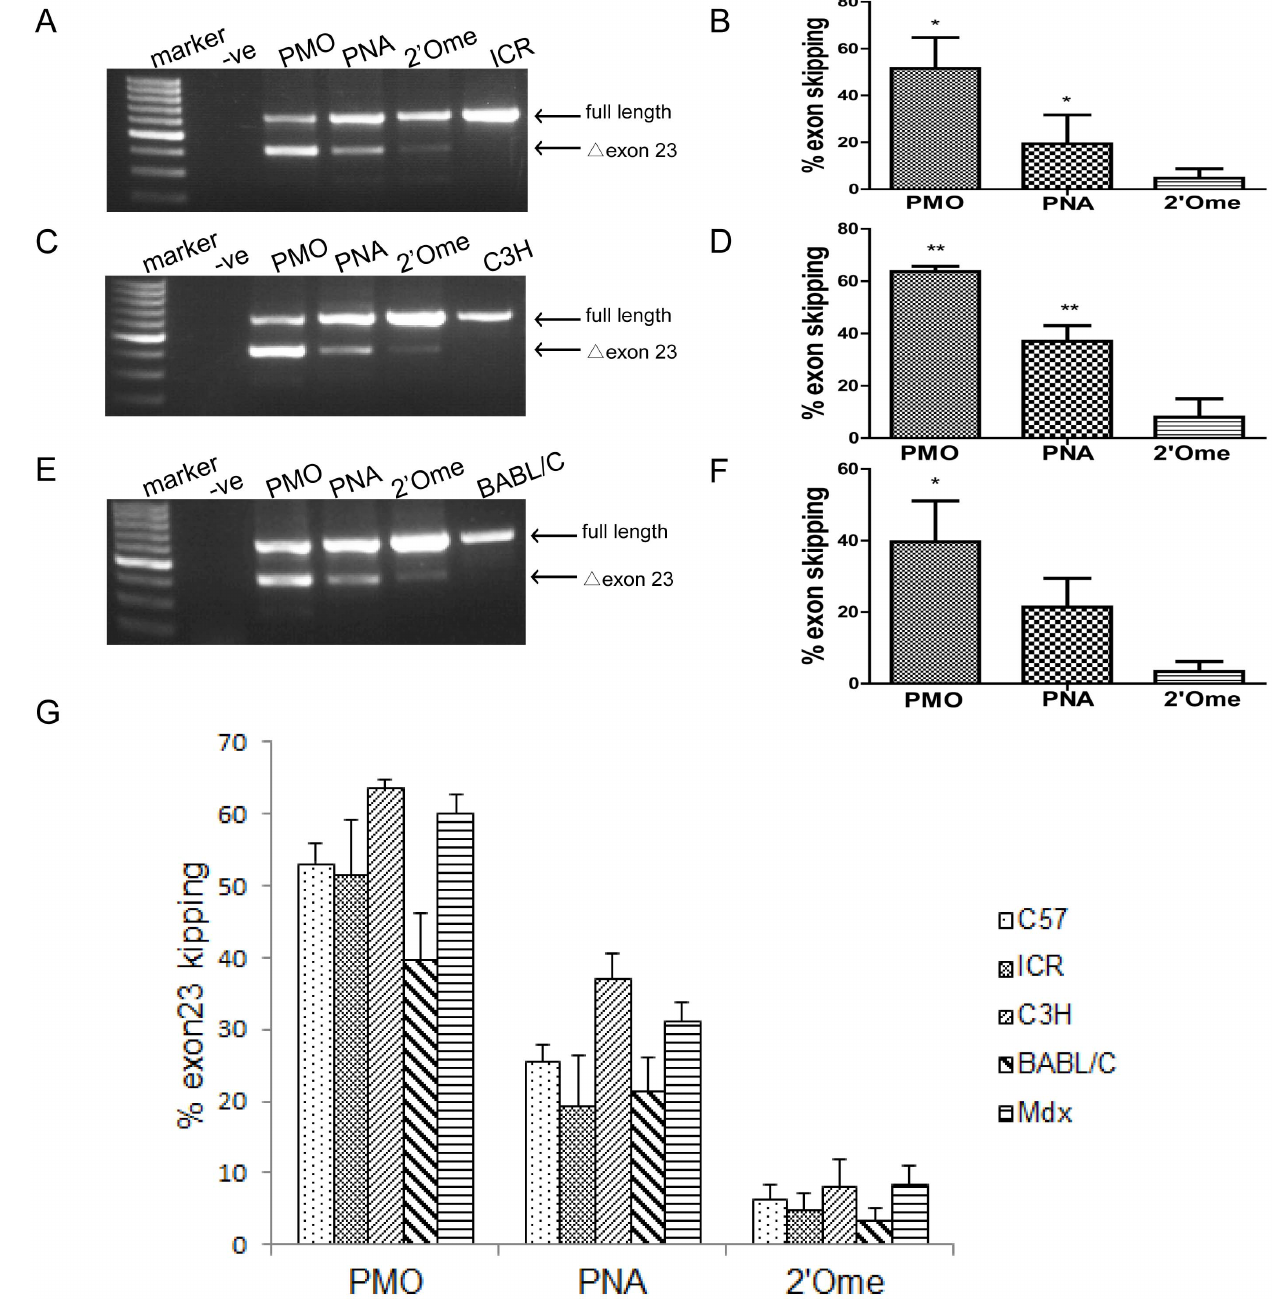
Figure 3. Efficient exon skipping in other wild-type mice by local intramuscular injection. (A) RT-PCR results for PMO, PNA and2 9 Ome PS in C3H mice 48 hr after local intramuscular injection. The numbered D exon23 is for exon 23 skipping. (B) Quantitative analysis of exon skipping induced by different AOs in C3H mice (*P , 0.05, n=3). (C) RT-PCR results for PMO, PNA and 2 9 Ome PS in ICR mice 48 hr post-injection. (D) Quantitative analysis of exon skipping efficiency by different AOs in ICR mice (**P , 0.001, n=3). (E) RT-PCR results for PMO, PNA and 2 9 Ome PS in BABL/C mice 48 hr post-injection. (F) Quantitative analysis of exon skipping induced by different AOs in BABL/C mice (*P , 0.05, n=3). (G) Cross- comparison between different wild-type and mdx mice per AO